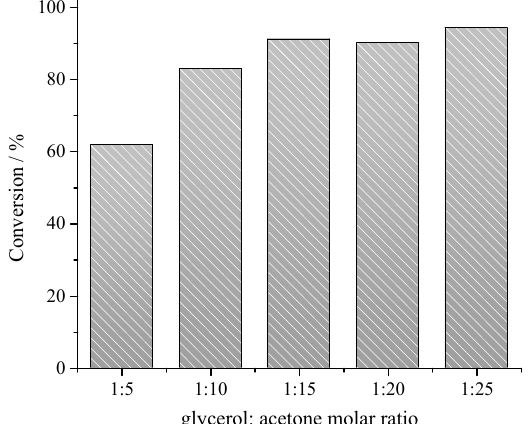
Figure 30. Impact of the glycerol: acetone molar ratio on the conversion of Fe 4/3 SiW 12 O 40 − catalyzed